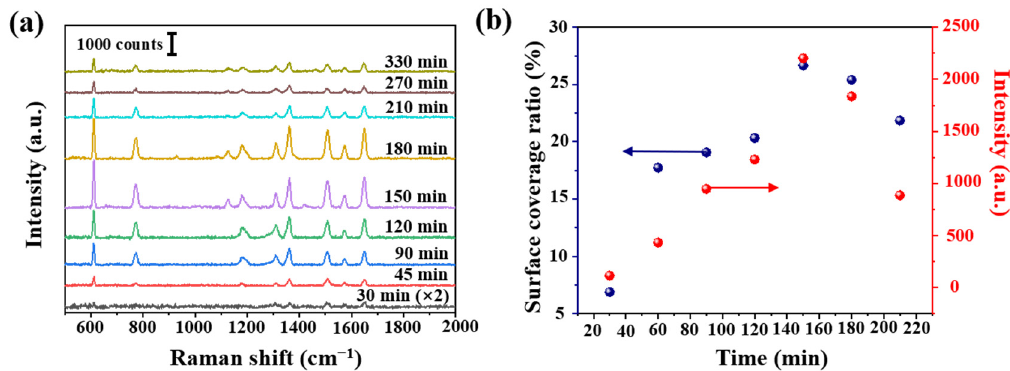
Figure 5. ( a ) R6G Raman intensity (10 − 7 mol/L) at different deposition time and ( b ) calculated Ag surface coverage ratio at Figures 6 different deposition time, and the corresponding Raman intensity at 611 cm − 1 from ( a ).